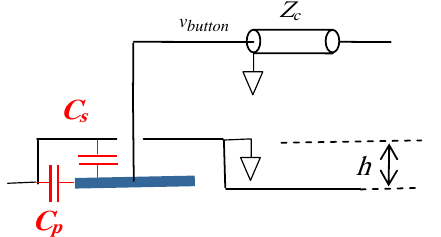
is the capacitance s ¼ C þ C is the b s p